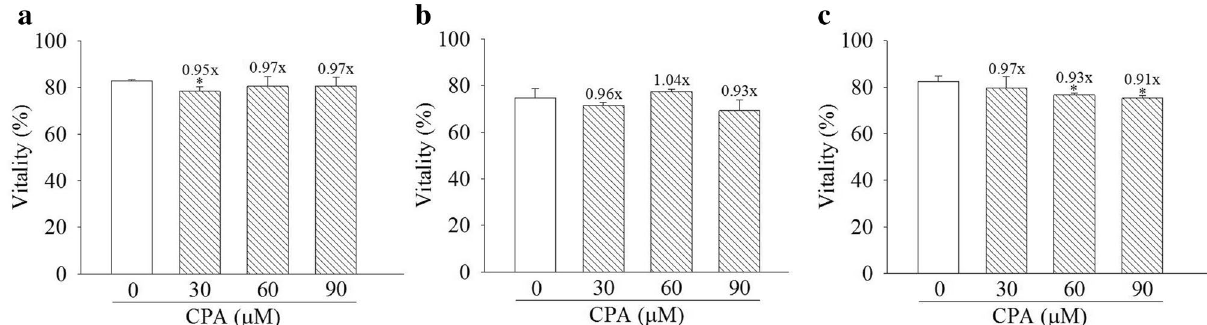
Figure 1. Vitality assay of cyproterone acetate (CPA)-treated cells. ( a ) HepG2, ( b ) MCF7 and ( c ) Hepa-1c1c7 cells were treated with CPA (30, 60 and 90 μM) for 48 h. Vitality rates are indicated by the percentage of healthy cells. Multiples of healthy cells among treated cells relative to those in the control are indicated at the top of bar. * Indicates comparison with DMSO-treated cells of healthy cells. Results are expressed as the mean ± SD, n = 3. * p <